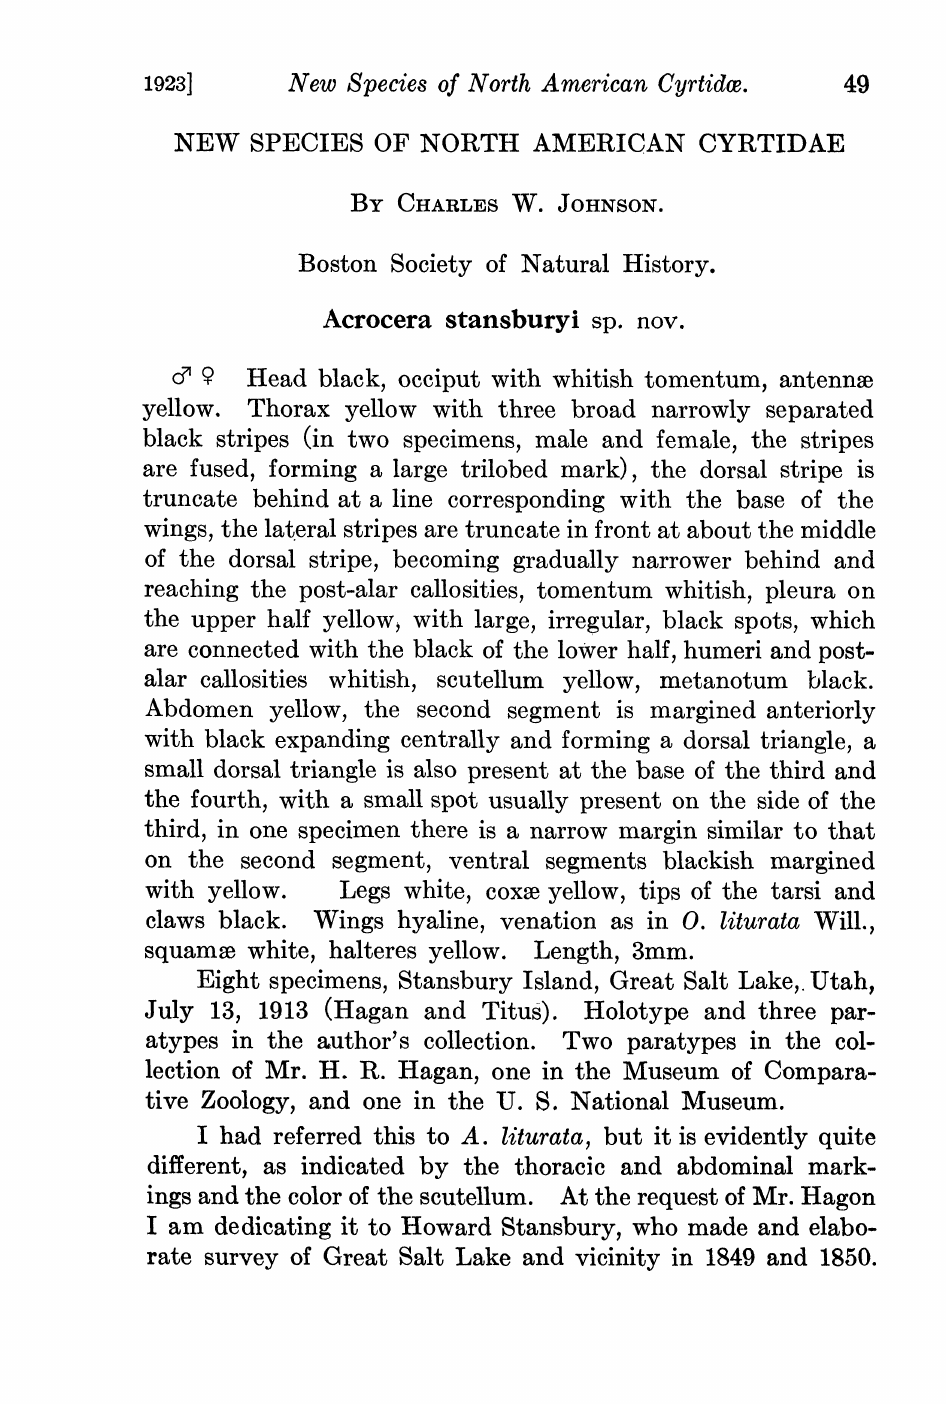
Thorax yellow with three broad narrowly separated black stripes (in two specimens, male and female, the stripes are fused, forming a large trilobed mark), the dorsal stripe is truncate behind at a line corresponding with the base of the wings, the lateral stripes are truncate in front at about the middle of the dorsal stripe, becoming gradually narrower behind and reaching the post-alar callosities, tomentum whitish, pleura on the upper half yellow with large, irregular, black spots, which are connected with the black of the loWer half, humeri and post- alar callosities whitish, scutellum yellow, metanotum black. Abdomen yellow, the second segment is margined anteriorly with black expanding centrally and forming a dorsal triangle, a small dorsal triangle is also present at the base of the third and the fourth, with a smll spot usually present on the side of the third, in one specimen there is a narrow margin similar to that on the second segment, ventral segments blackish margined with yellow. Legs white, coxe yellow, tips of the tarsi and claws